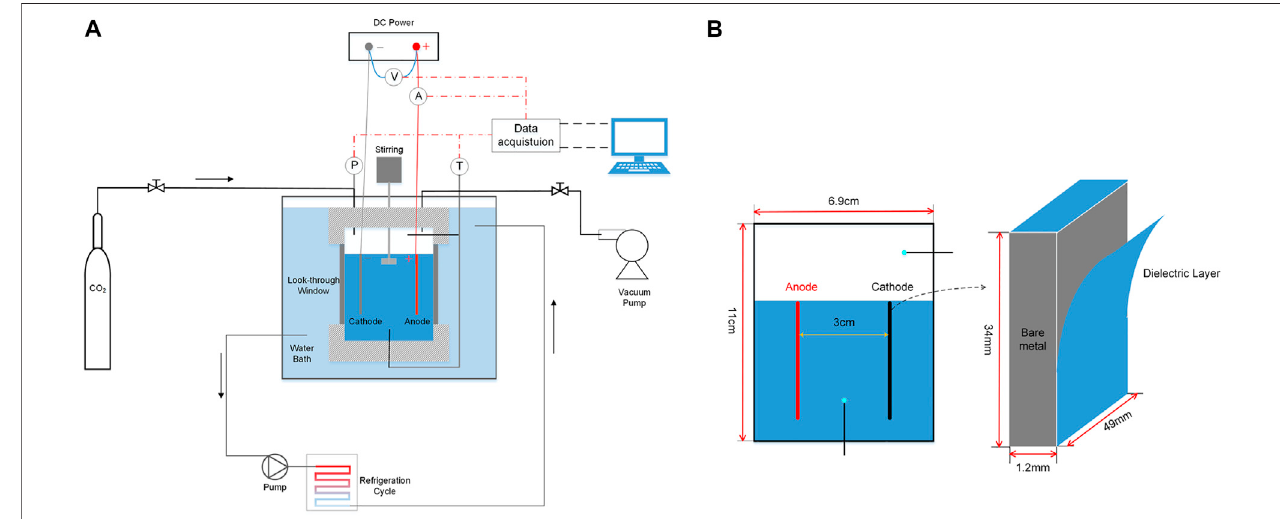
FIGURE 1 | (A) Schematic of the experimental setup; (B) Details of the electrodes inside the